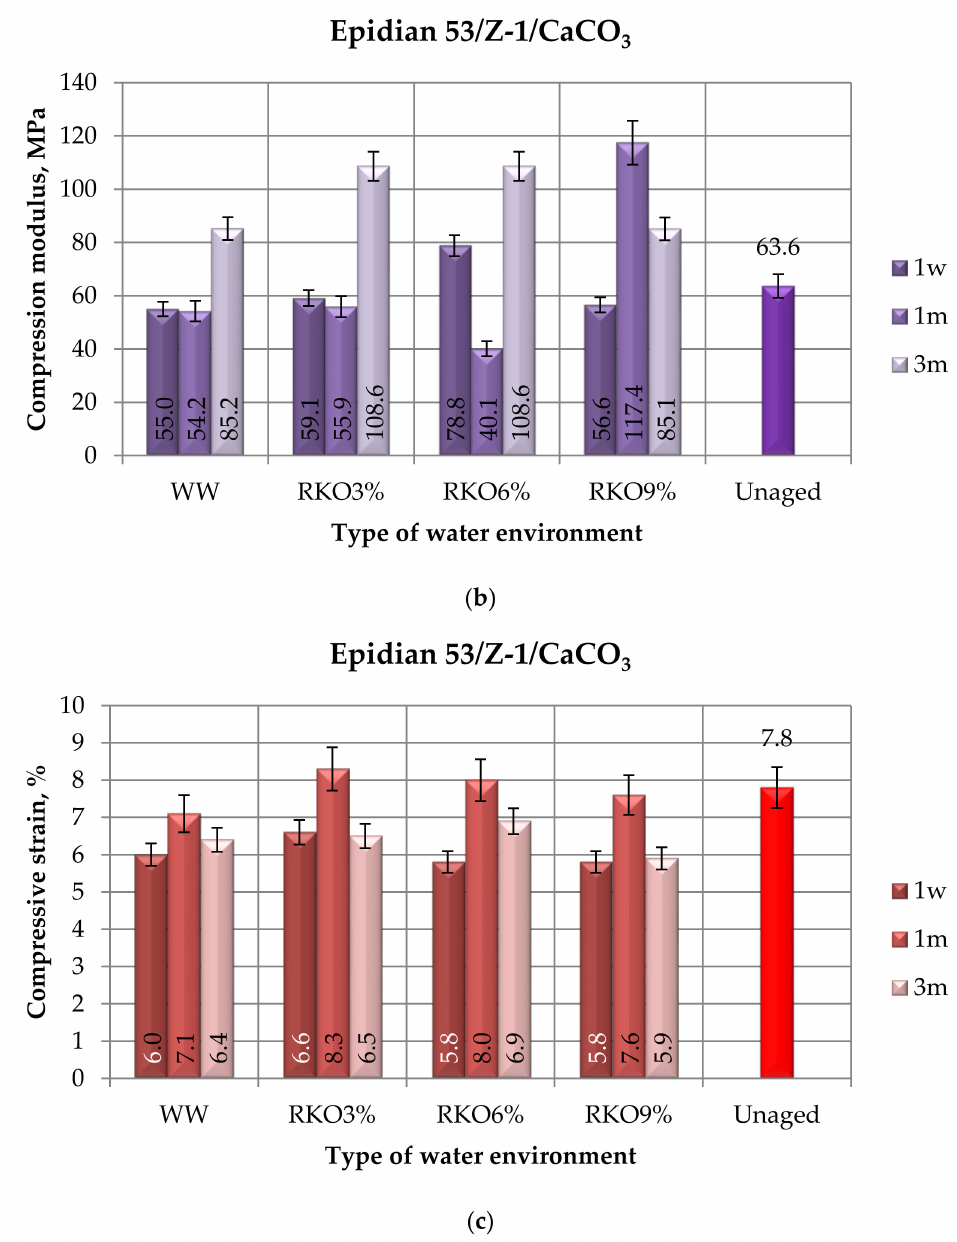
Figure 4. Results of the compression tests of the modified epoxy compound (Epidian 53 / Z-1 / CaCO 3 ) seasoned in four water environments for the following periods of time: one week, one month, and three months: ( a ) compressive strength, ( b ) compression modulus, ( c ) compressive